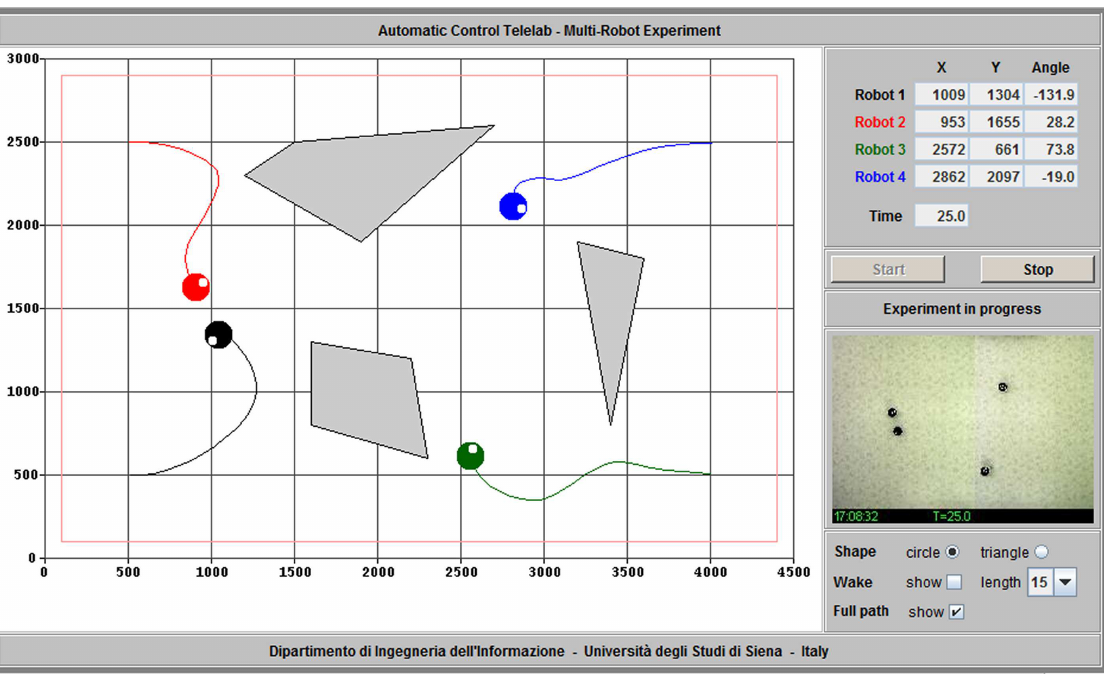
Figure 6. The user